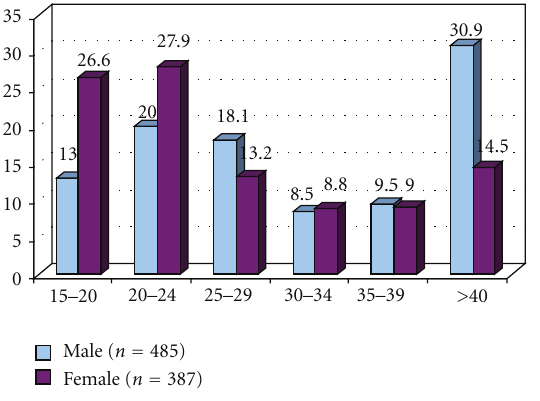
Table 1: Sociodemographic characteristics and living condition.